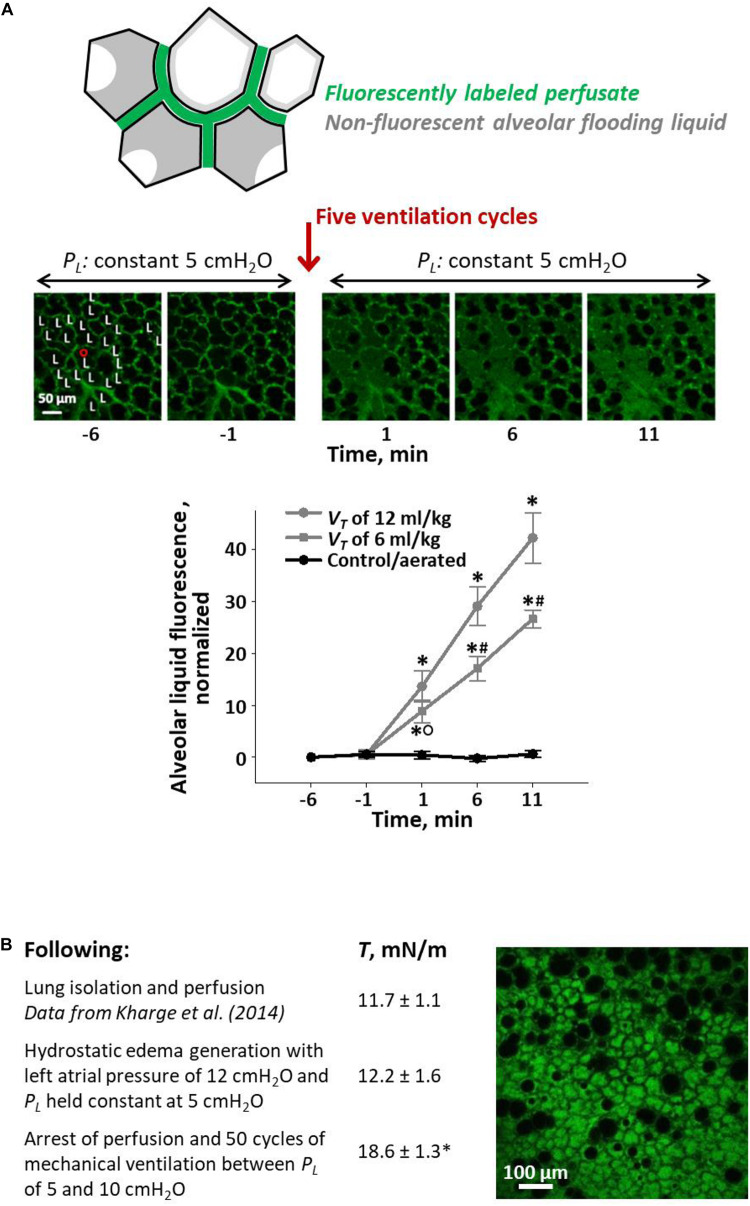
Ventilation-induced lung injury (VILI) assays. (A) Local VILI assay of ventilation-induced injury to alveolar–capillary barrier in the presence of heterogeneous alveolar flooding. Top schematic: Isolated lung is perfused with fluorescein-labeled blood/5% albumin mixture. A glass micropipette is used to puncture a surface alveolus and infuse non-fluorescent 3% albumin solution, which causes heterogeneous alveolar flooding in a local region. Menisci are present in flooded alveoli. Middle images: With PL held at 5 cm H2O, the region is imaged by confocal microscopy over 5-min baseline period. “L” labels alveoli flooded with non-fluorescent liquid. Then, five ventilation cycles are administered with an end-expiratory PL equivalent to an in vivo positive end-expiratory pressure (PEEP) of 10 cm H2O and a tidal volume, VT, of 12 ml/kg. Following ventilation, PL is returned to 5 cm H2O, and the region is imaged for 10 additional minutes. Bottom graph: plot of increase above baseline of normalized fluorescence in alveolar liquid vs. time. Gray: experimental, heterogeneously flooded regions in lungs subjected to five ventilation breaths with 10 cm H2O PEEP and VT as specified (fluorescein intensity quantified in alveolar flooding liquid). Black: control, aerated regions in lungs subjected to five ventilation breaths with 10 cm H2O PEEP and 6 or 12 ml/kg VT (data for two VT groups combined; fluorescein intensity quantified in liquid lining layer). Statistics: ∗p < 0.01 vs. baseline; #p < 0.01 vs. both other groups at the same time point; °p < 0.01 vs. control group at the same time point. Figure modified, with permission, from Wu et al. (2014). (B) Global VILI assay of ventilation-induced increase in T in the presence of heterogeneous alveolar flooding. Table: summary of experimental protocol and T-values, all determined at PL of 15 cm H2O, at different time points. Statistics: ∗p < 0.05 vs. T-values at two earlier time points. Image: representative view of alveolar flooding pattern on surface of lungs at final time point after induction of VILI and elevation of T. Alveolar edema liquid labeled by fluorescein administered to the perfusate. Figure modified, with permission, from Wu et al. (2017).